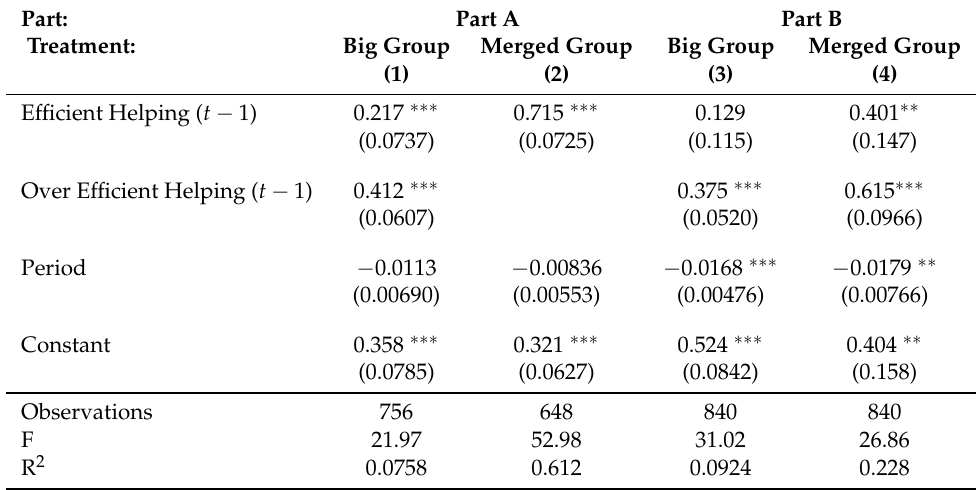
Table A12. Linear regressions: individual helping—coordination on